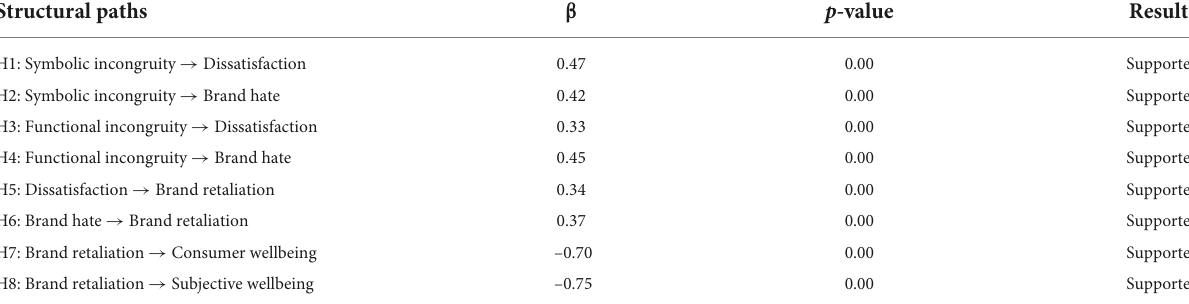
TABLE 5 Analysis of the